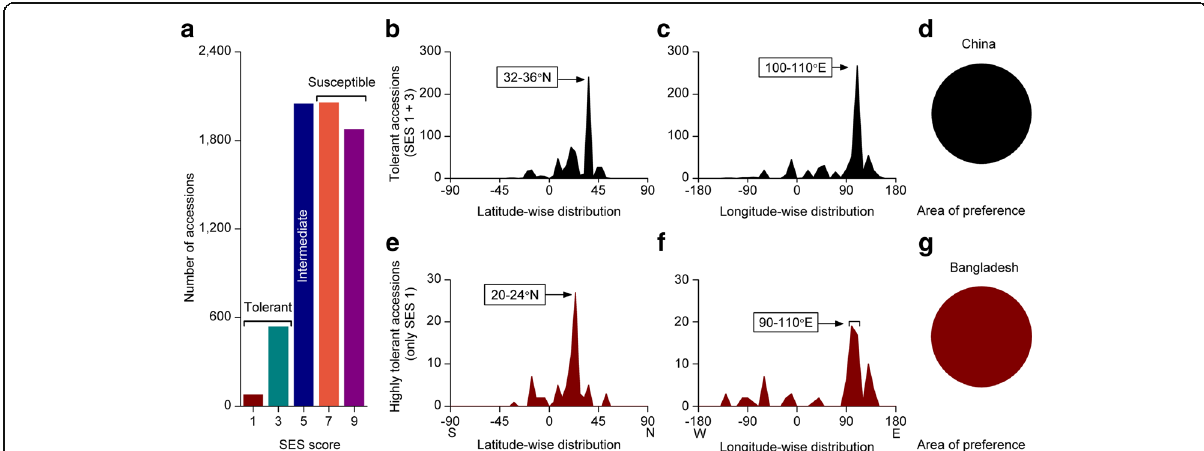
Fig. 9 Geographic distribution pattern of cold tolerant rice accessions. a Extent of cold tolerant accessions, b - d Geographic distribution pattern of cold tolerant (SES score 1-3) accessions, b Latitude-wise distribution, c Longitude-wide distribution, d Area of preference, e - g Geographic distribution pattern of highly cold tolerant (SES score 1) accessions, e Latitude-wise distribution, f Longitude-wide distribution, g Area of preference. List of highly tolerant accessions can be found in Additional file 4: Table